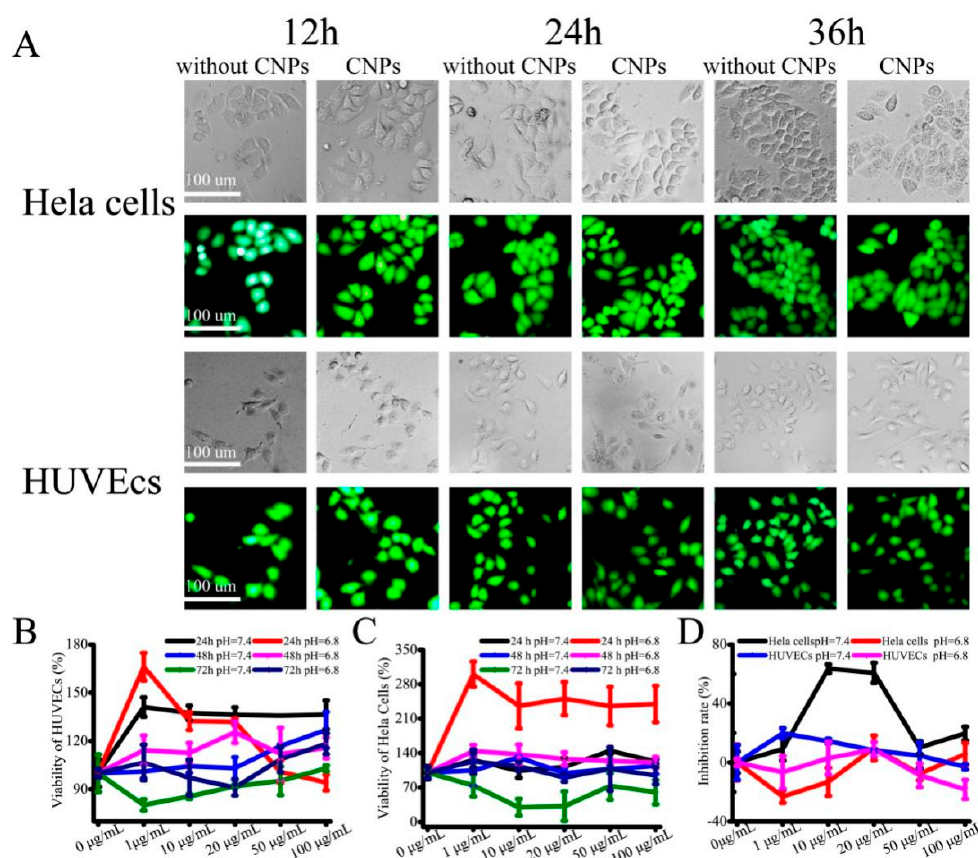
Figure 4. Cytotoxicity in vitro of designed CNPs. ( A ) Fluorescent images of Hela cells and HUVECs (stained with calcein-AM / PI) treated with 10 µ g / mL CNPs. Time-dependent viability of cultured HUVECs ( B ) and Hela cells ( C ) treated with CNPs at different concentrations. ( D ) Concentration-dependent cell inhibition.